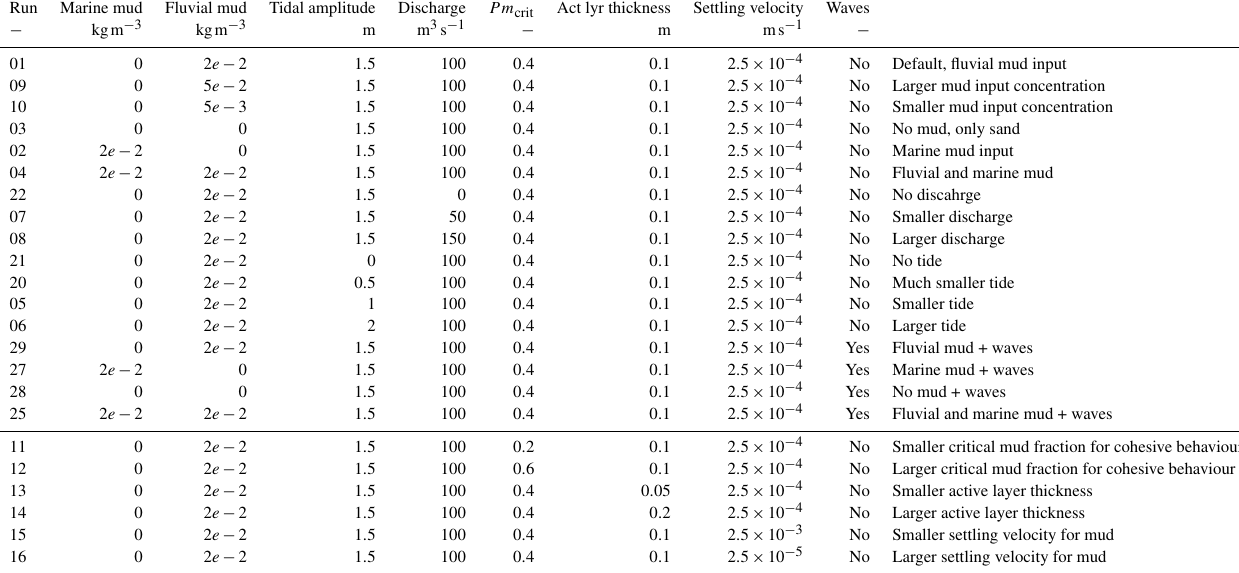
Table 3. Overview of all model scenarios and runs to examine sensitivity to mud-related